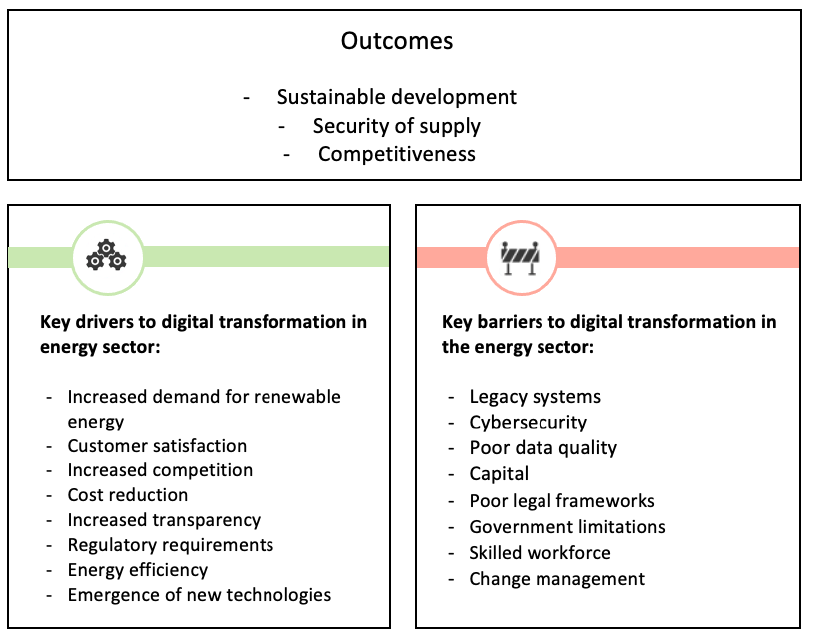
Figure 4. The key drivers of and barriers to digital transformation process in the energy